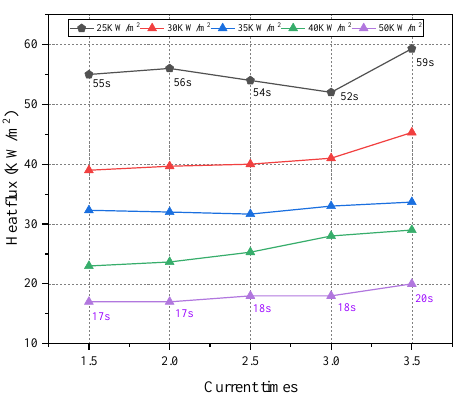
Figure 5. TTI under various external heat flux and current times.